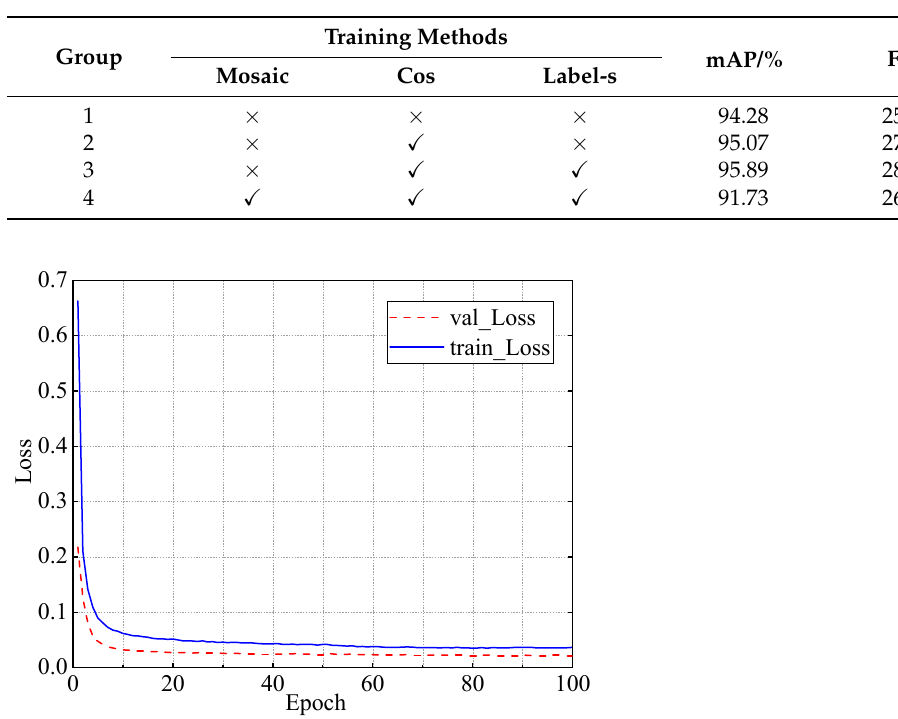
Table 4. Comparison of training methods.